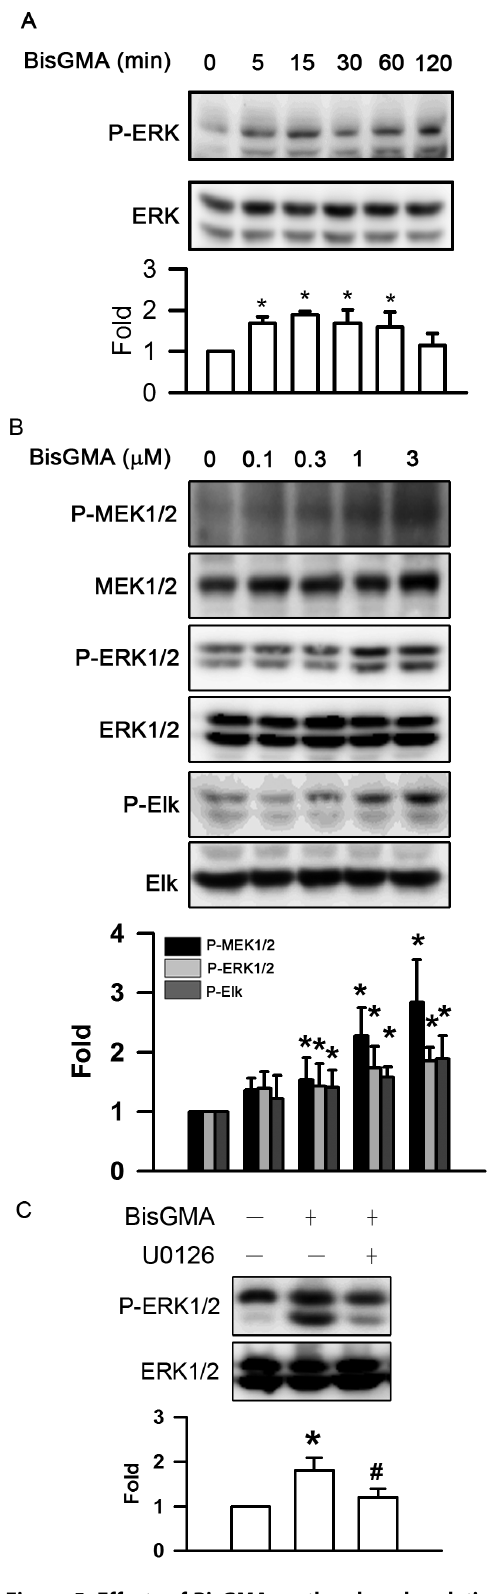
Figure 5. Effects of BisGMA on the phosphorylation of ERK1/2 pathway. (A) RAW264.7 macrophages were stimulated with 3 m M BisGMA for the indicated treatment periods. Cells were harvested and protein extracts were subjected to SDS-PAGE. Western blot analysis